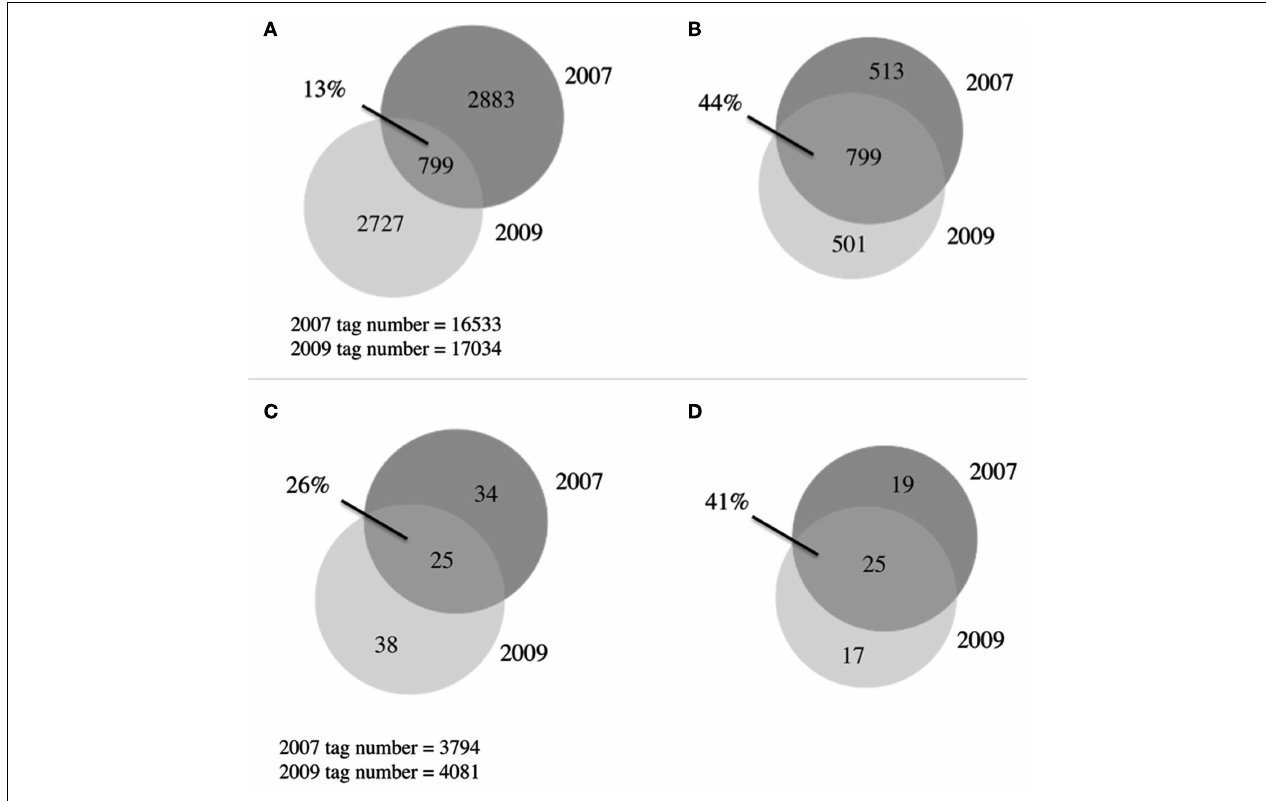
FIGURE 4 |Venn diagrams of microbial communities. (A) Overlap between 2007 and 2009 bacterial communities, OTUs defined at 97% similarity (B) As in (A) with singletons removed (C) overlap between 2007 and 2009 eukaryotic communities, OTUs defined at 94% similarity, (D) as in (C) with singletons